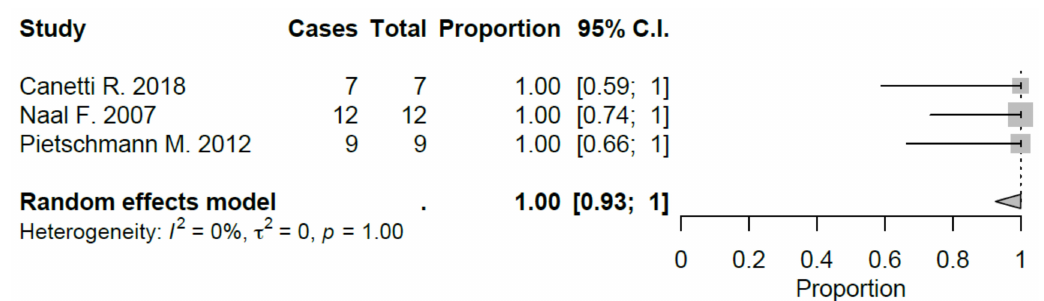
Figure 6. Return to alpine ski after UKA (C.I.: Confidence Intervals).